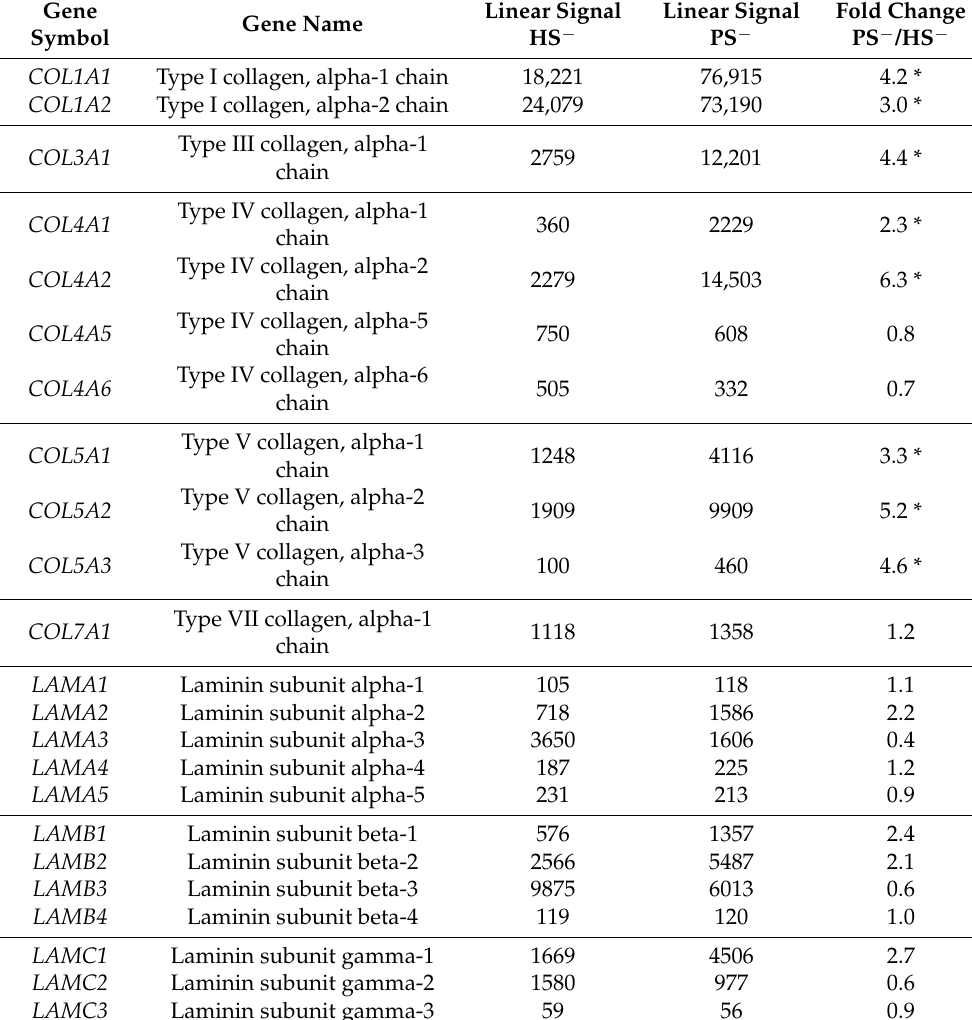
Table 1. Expression of genes encoding collagens in healthy and psoriatic skin